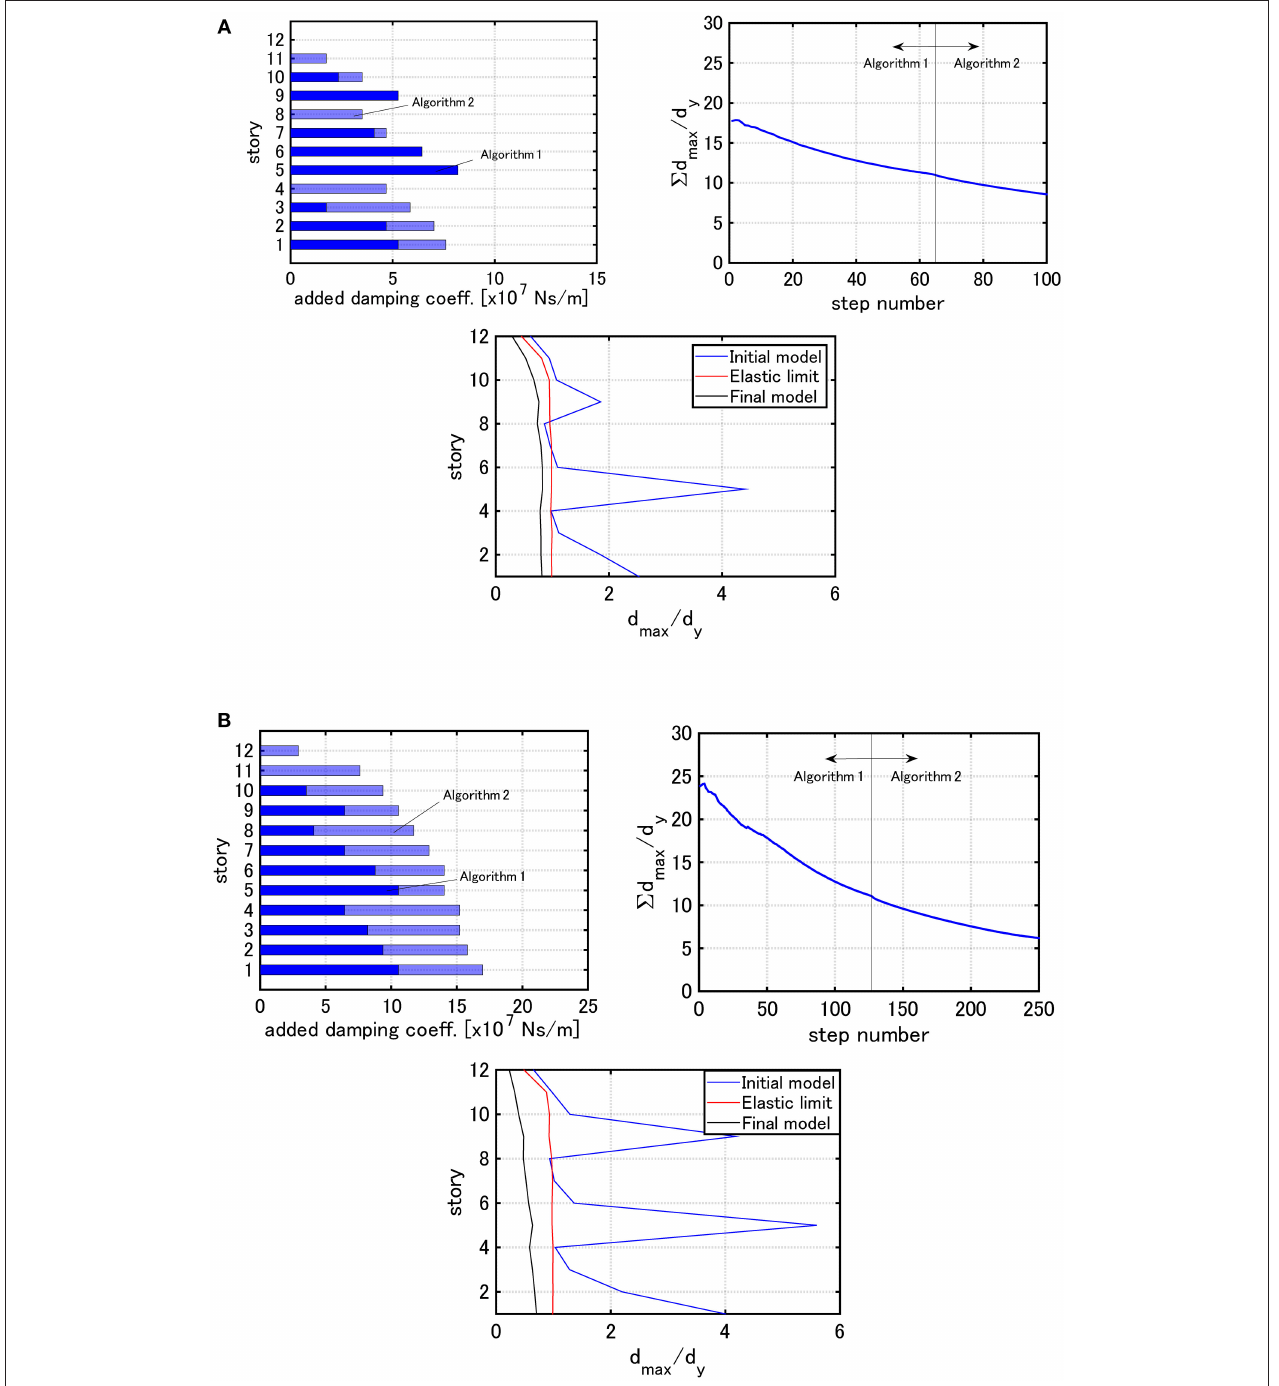
FIGURE 14 | Distribution of added damping coefficients, P d max , i / d y with respect to step number and the distribution of d max , i / d y under the critical double impulse for Model 3 (Problem 3): (A) V = 0.84[m/s], (B) V =